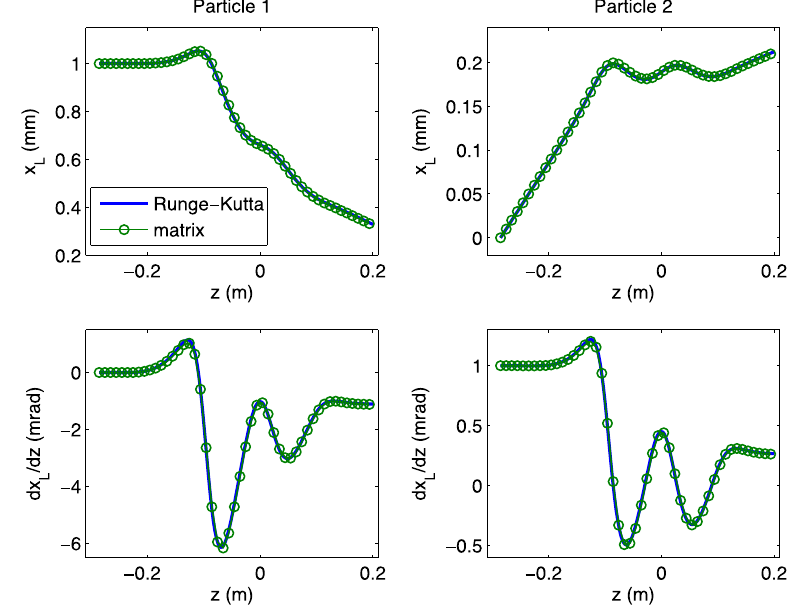
FIG. 4. Comparison of direct integration (blue) and tracking using the transfer matrix (green) of the two principle trajectories.